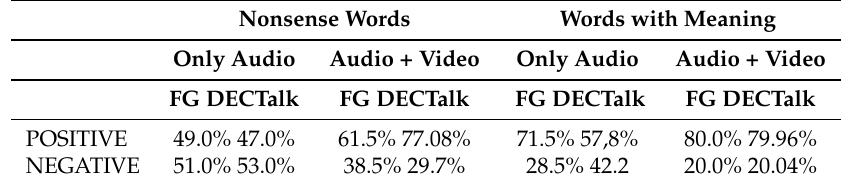
Table 2. Naturalness results of synthetic utterances for nonsense words and words with meaning.